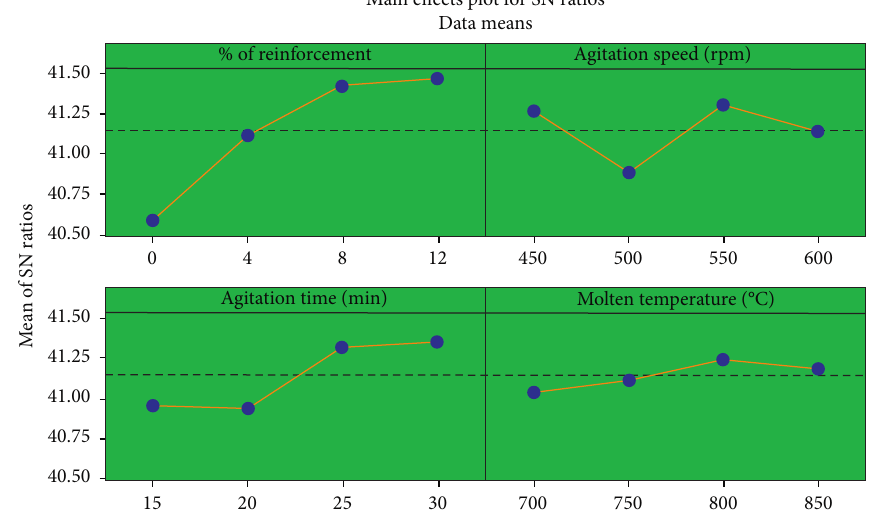
Figure 12: Main Effects plot for S/N ratios (Vickers hardness test).